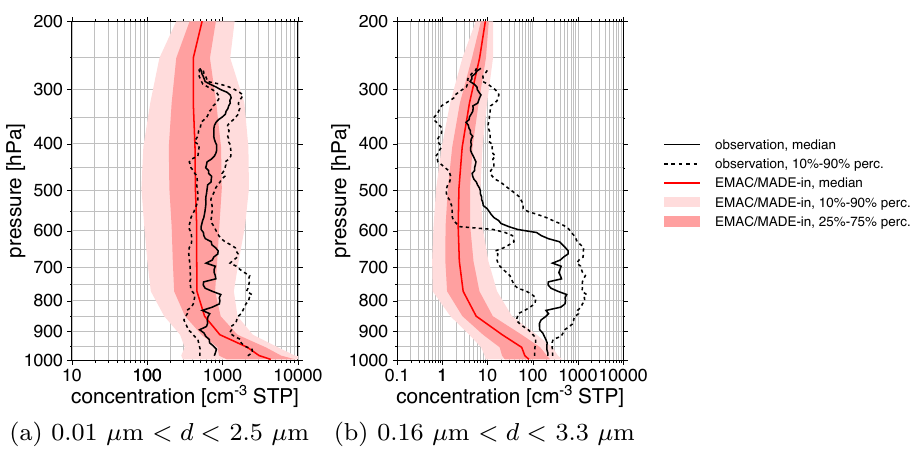
Fig. 9. Vertical profiles of the aerosol number concentration (converted to STP conditions: 273K, 1013hPa) measured by Weinzierl et al. (2009) during SAMUM over southern Morocco in May/June 2006 and corresponding model data. Shown are the number concentrations of aerosol particles with diameters between 10nm and 2.5µm (a) and between 160nm and 3.3µm (b)